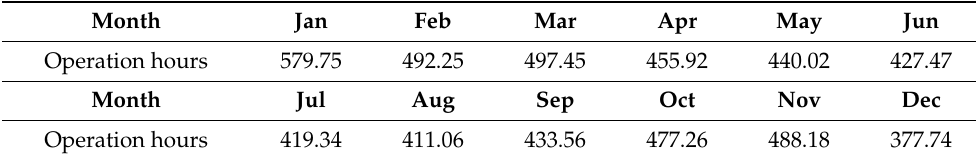
Table 6. Operation hours of the power plant in this